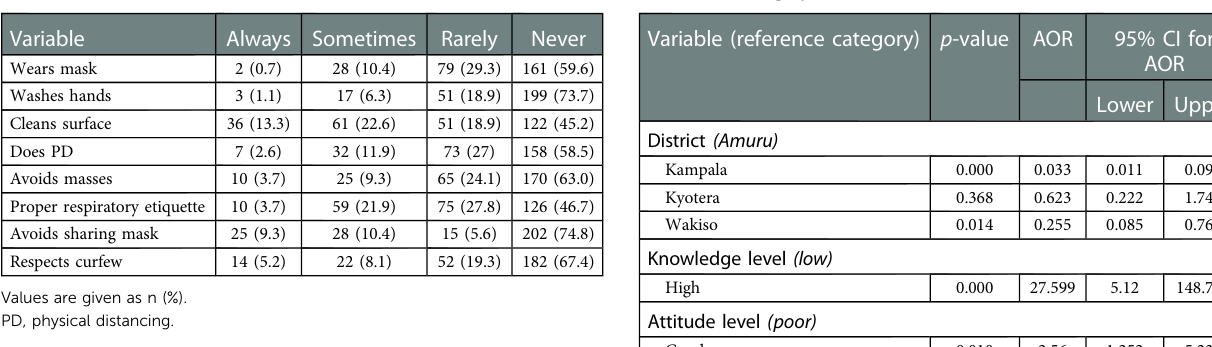
TABLE 10 Logistic regression for the relationship between adherence levels and demographic